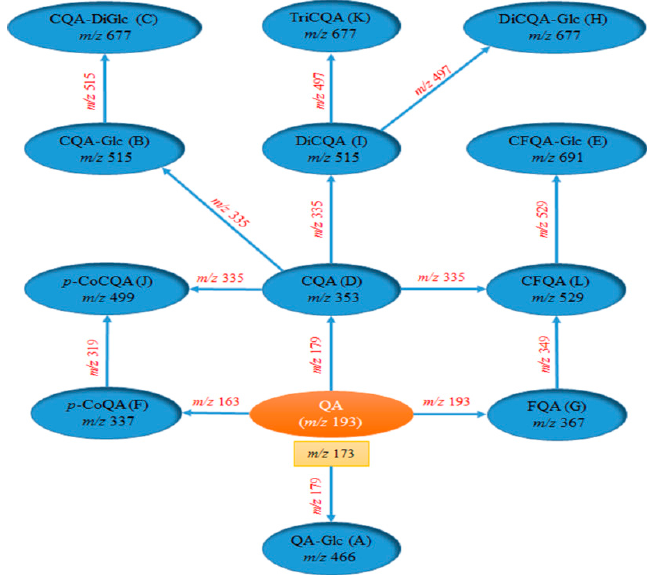
Figure 3. The DPI network of 12 categories of CGAs identified in the present study.